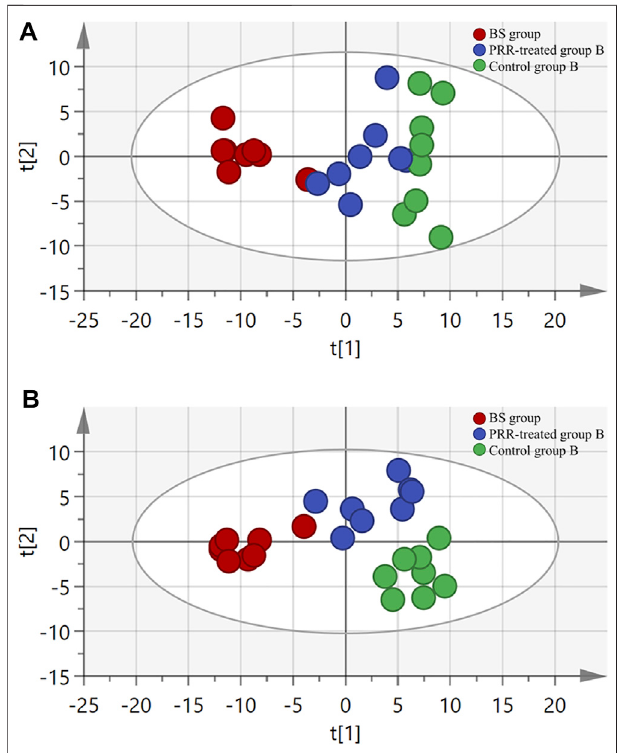
FIGURE 5 | The relationship of metabolic phenotypes among three groups in BS stage. (A) PCA plot. (B) PLS-DA plot. R 2 X and Q 2 Y of PCA are 0.761 and 0.665; R 2 X and Q 2 Y of PLS-DA are 0.775 and 0.803. The CV- ANOVA p value of PLS-DA was less than